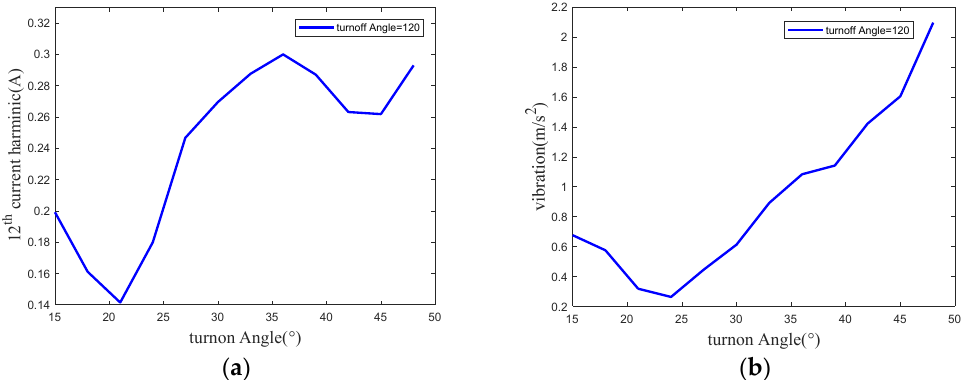
Figure 9. The 12th current harmonic and the 2nd vibration value under different turn-on angles (15–48°) ( a ) Variation curve of 12th order current harmonic with turn-on angle ( b ) Variation curve of second-order vibration amplitude with turn-on angle.